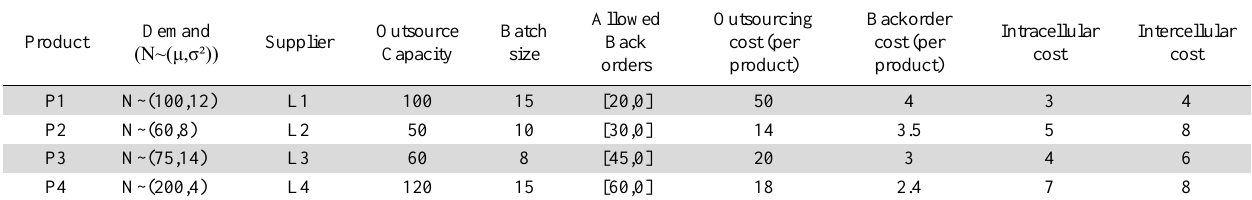
Product dataset for experiment number 1